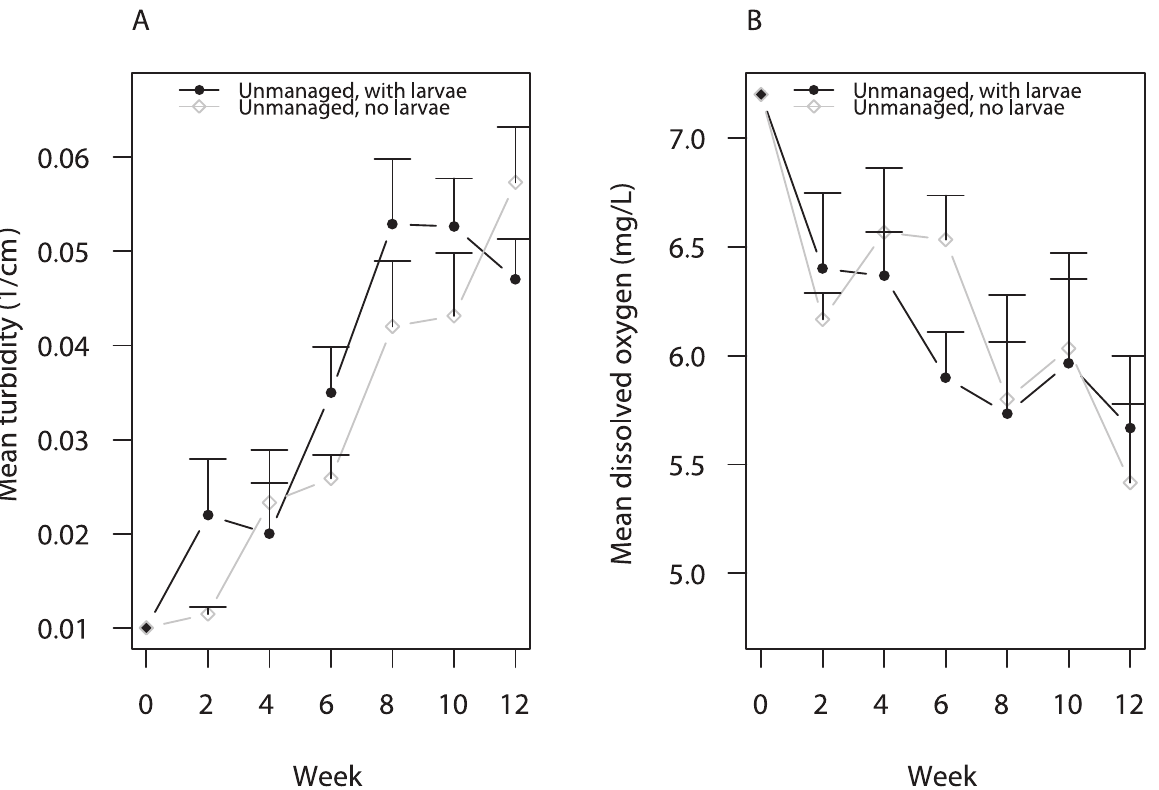
Figure 5. Mean turbidity ( ± SE) and mean dissolved oxygen ( ± SE) in unmanaged containers over 12 weeks. Measurements were averaged across all three houses at each time point. Water turbidity (a) was assessed using a 100 cm-long turbidity tube with a Secchi disk affixed to the end. Turbidity was measured as the inverse water depth (1/cm) at which the black and white portions of the Secchi disk were no longer distinguishable. Dissolved oxygen content (b) was measured in mg/L using an Ecological Test Kit (Rickly Hydrological Company, Columbus,